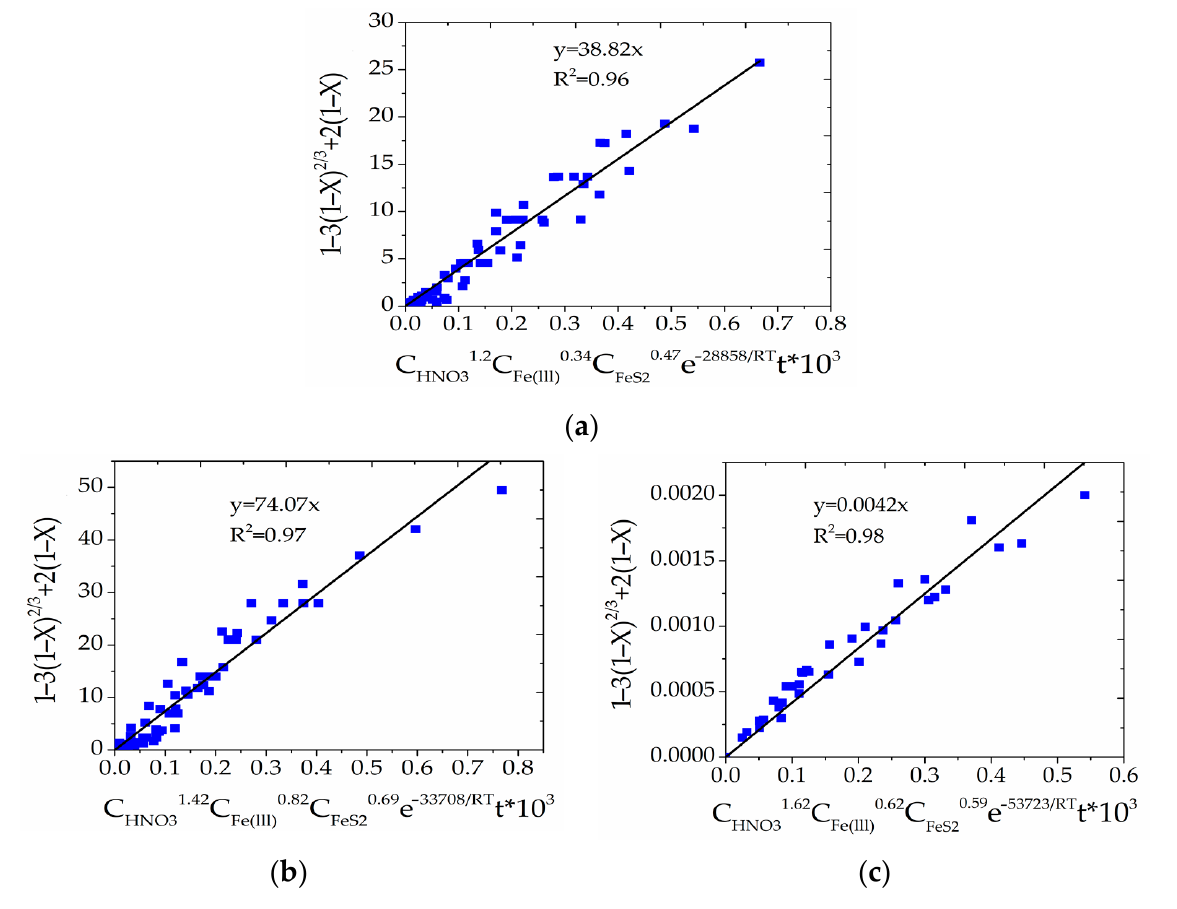
Figure 12. Relationship between SCM equation and C HNO3 · C Fe(III) · C FeS2 · exp[ − E a /(R · T)] · τ · 10 3 for the treatment of Cu 12 As 4 S 13 ( a ), CuFeS 2 ( b ) and ZnS ( c